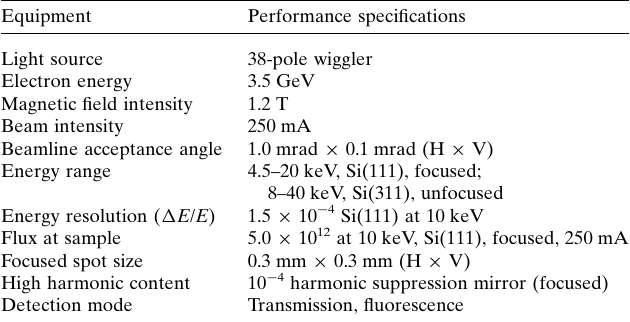
Table 1 Main performance specifications of the XAFS beamline. Equipment